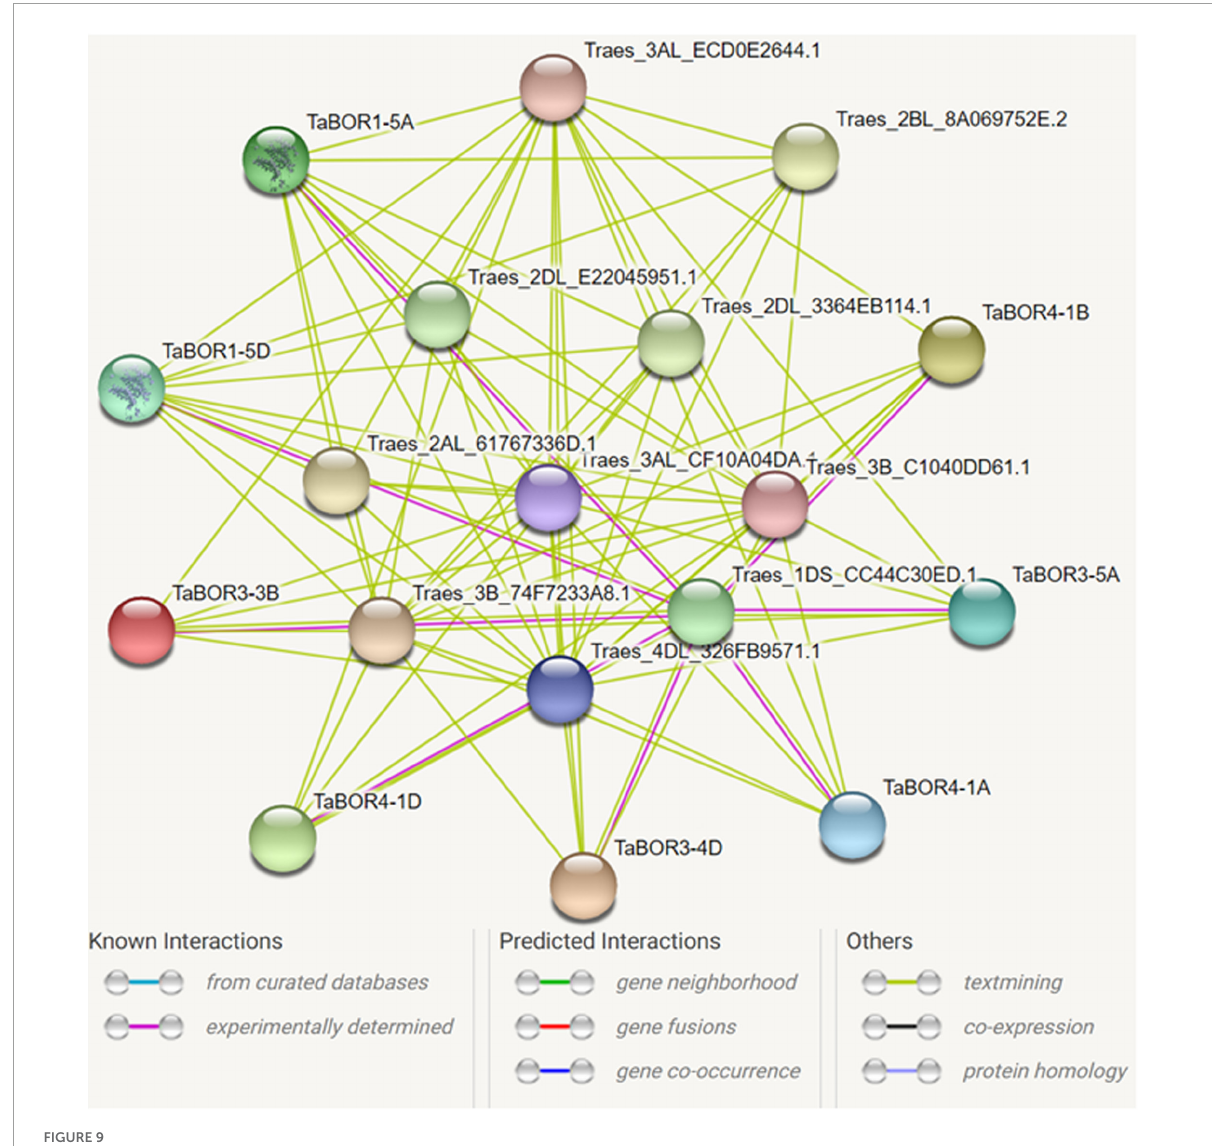
FIGURE9 Protein interaction network of TaBOR s produced by STRING V9.